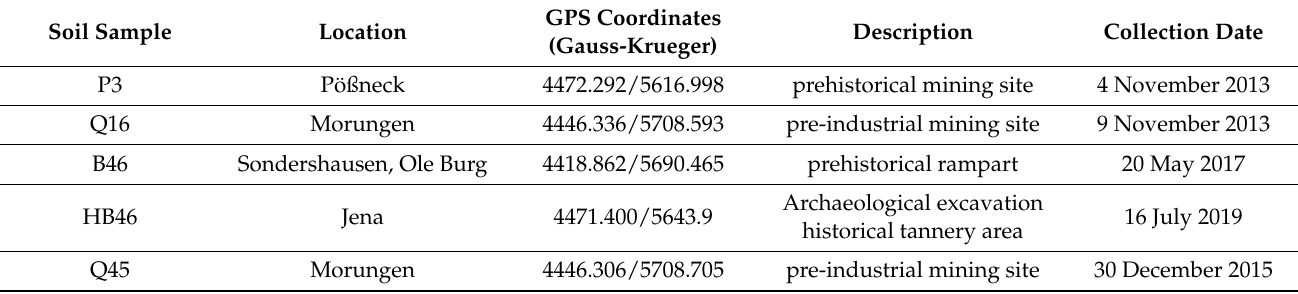
Table 1. Soil sample